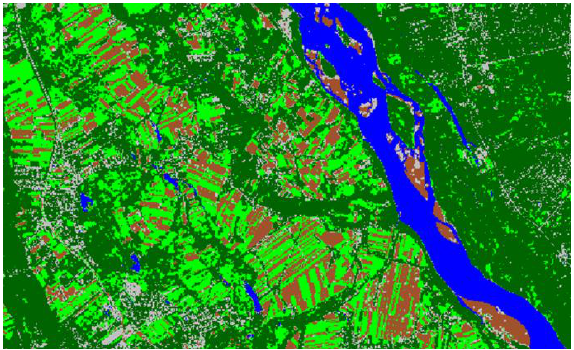
Figure 4. Results of the automatic image classification model: (1) “water” – blue, (2) “forest” – dark green, (3) “low vegetation” – light green, (4) “bare soil”– brown, (5) “built-up area”–